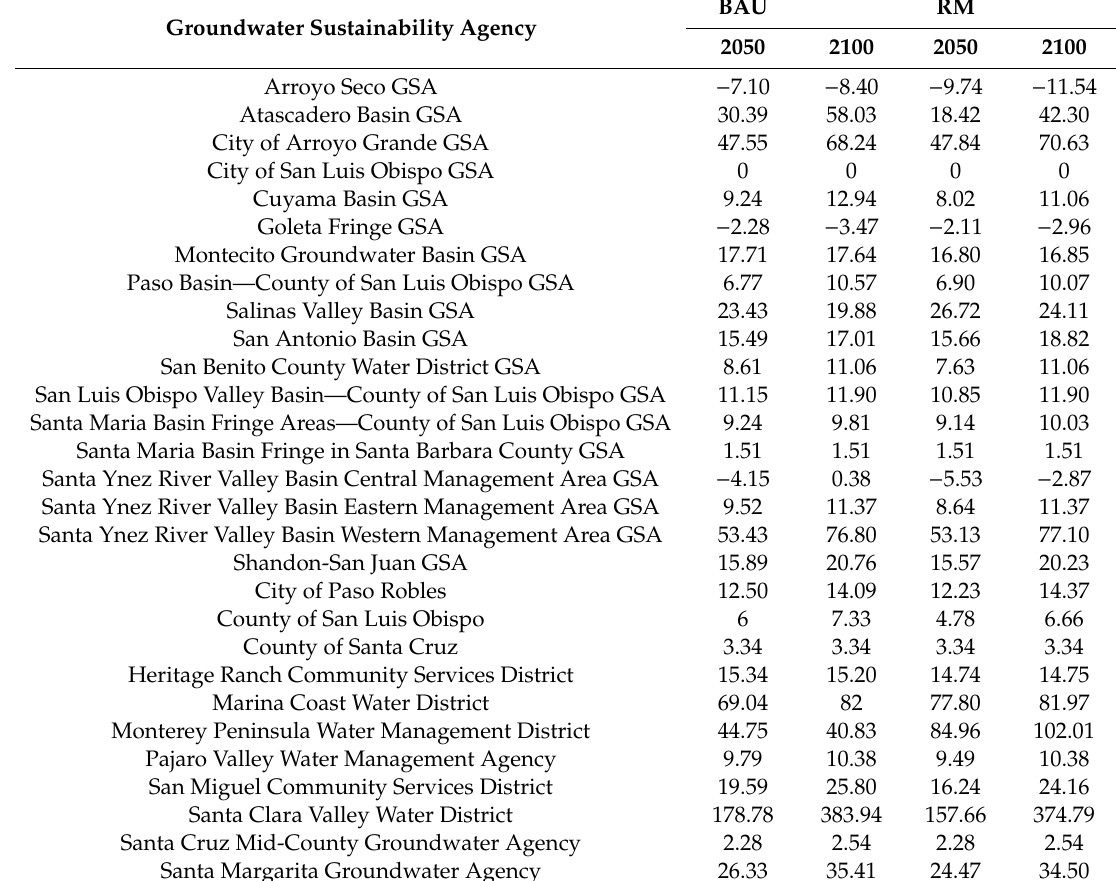
Table 1. Projected percent (%) change in water demand for SGMA groundwater sustainability agencies of the Central Coast by 2050 and 2100 under two scenarios, a Business-as-Usual (BAU; fit to 1992–2016 land use change rates) and Recent-Modern (RM; fit to 2002–2016).